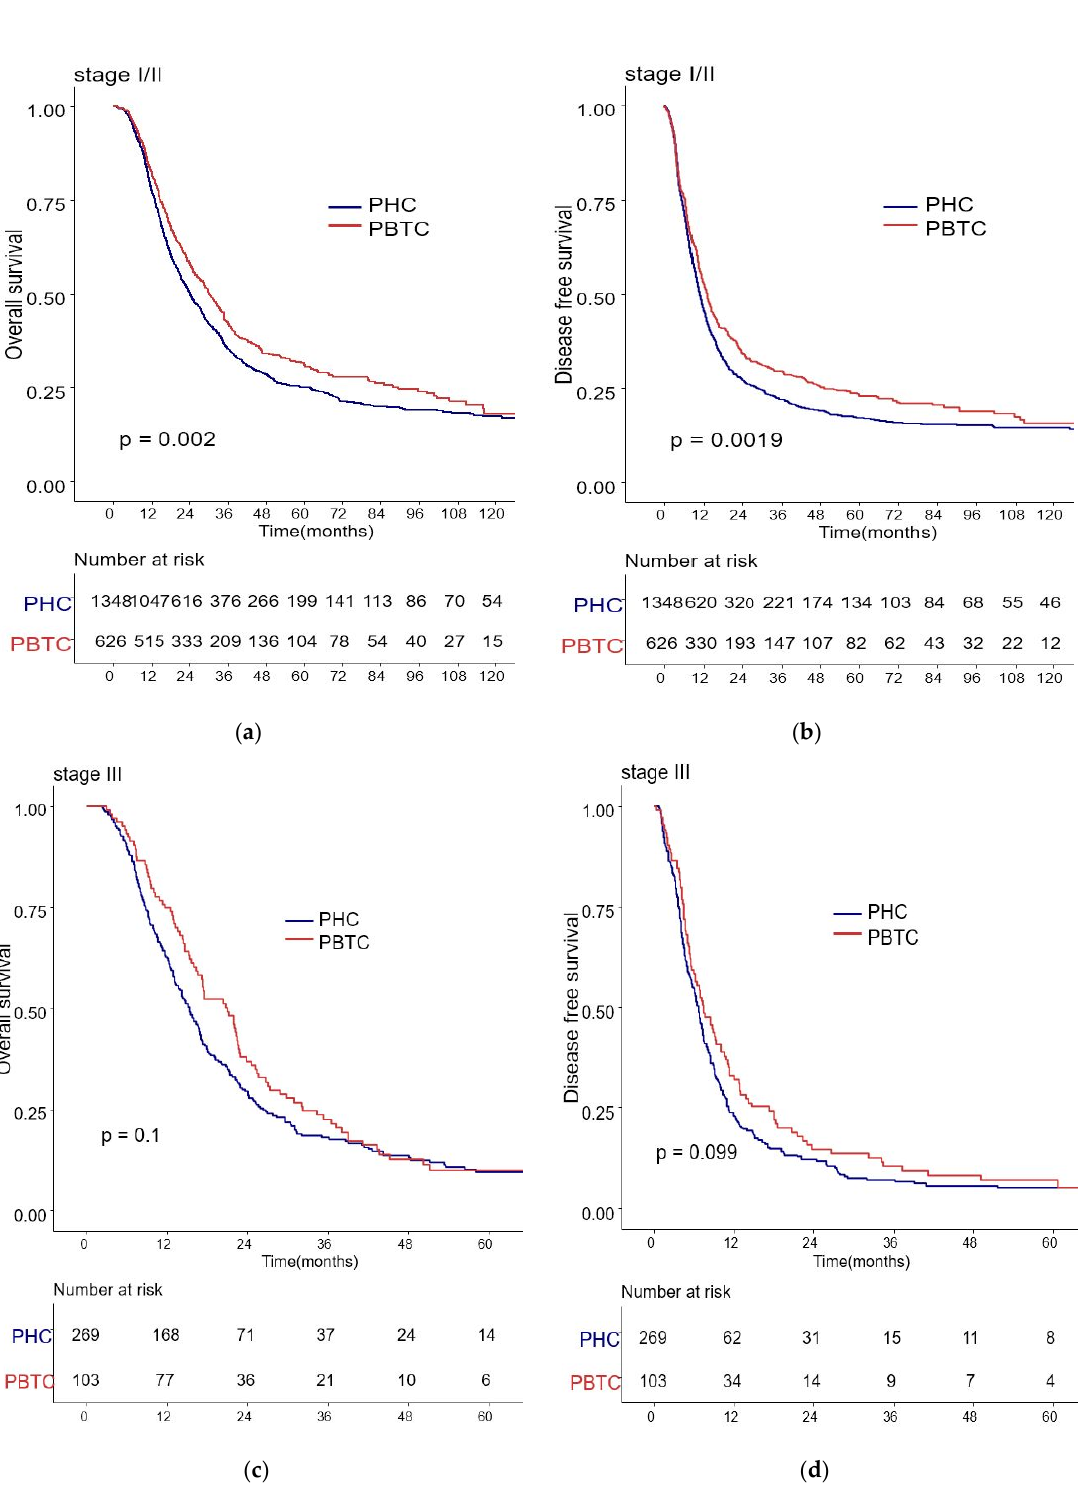
Figure 1. Kaplan–Meier survival curves of the cases in pancreatic head cancer (PHC) group ( n = 1677) and pancreatic body/tail cancer (PBTC) group ( n = 704). ( a ) The median overall survival (OS) and estimated 1-, 3-, and 5-year OS rates were 24.0 months and 75.0%, 25.2%, and 13.0% in the PHC group, and 34.0 months and 79.5%, 30.6%, and 14.7% in the PBTC group, respectively ( p = 0.001). ( b ) The median disease-free survival (DFS) and estimated 1-, 3-, and 5-year DFS rates were 12.0 months and 41.5%, 14.3%, and 8.6% in the PHC group, and 18.0 months and 48.4%, 20.7%, and 11.5% in the PBTC group, respectively ( p = 0.0012).